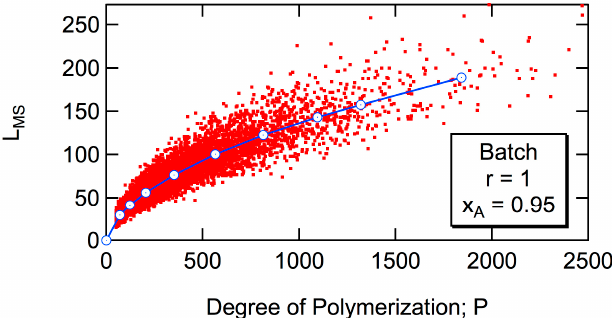
Figure 15. Relationship between L MS and P with r = 1 and x A = 0.95 for batch polymerization.